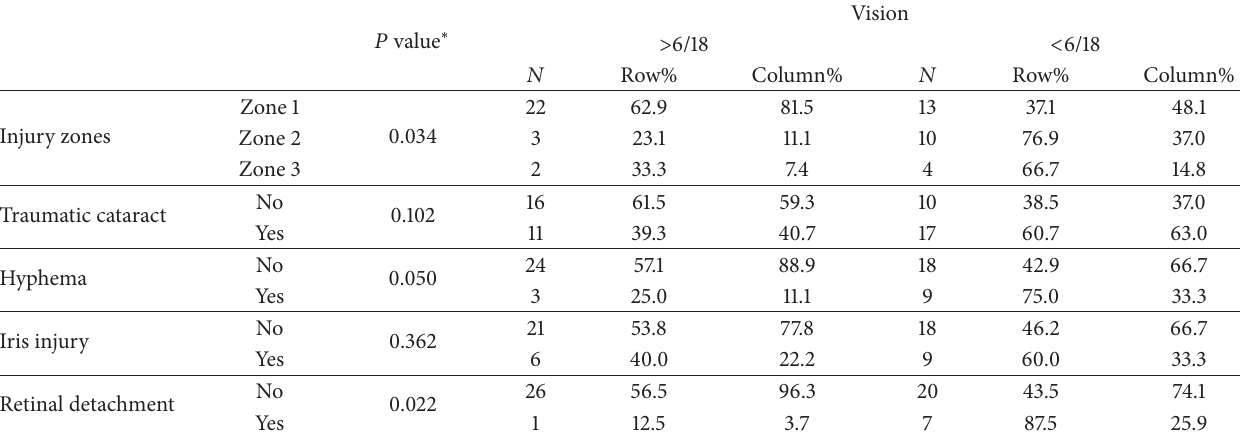
Table 3: The relationship between decreased vision and initial examination